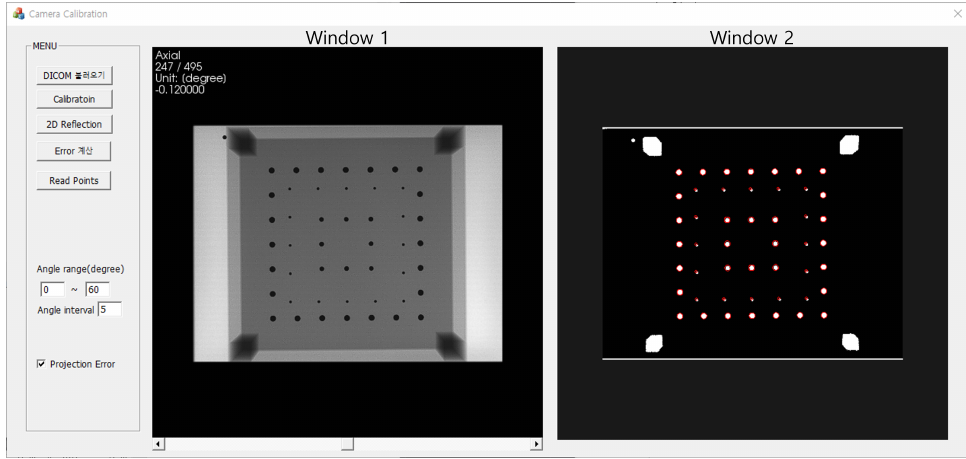
Figure 7. Software application for the geometric calibration of X-ray imaging was implemented, which provides core functions for the calibration and graphical user